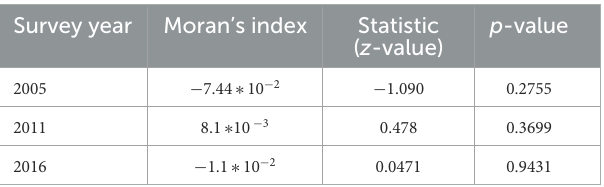
TABLE 4 Variogram output of autocorrelation statistics across 2005, 2011, and 2016. Survey year